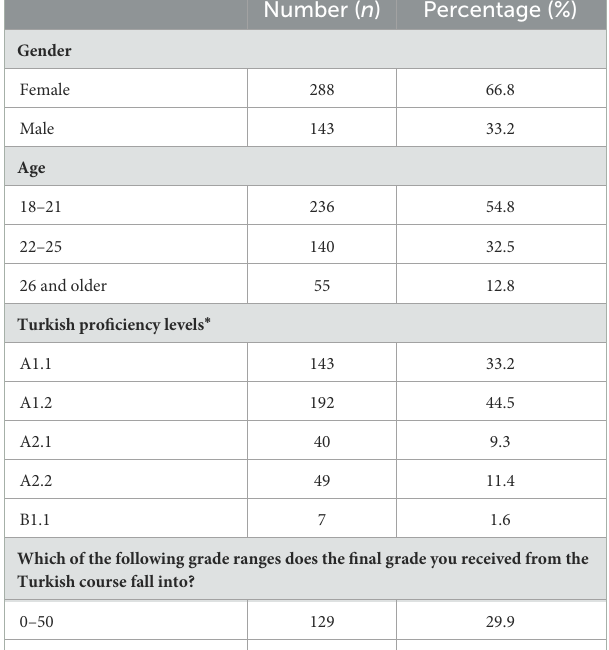
TABLE 1 Sociodemographic characteristics of the university students who participated in the